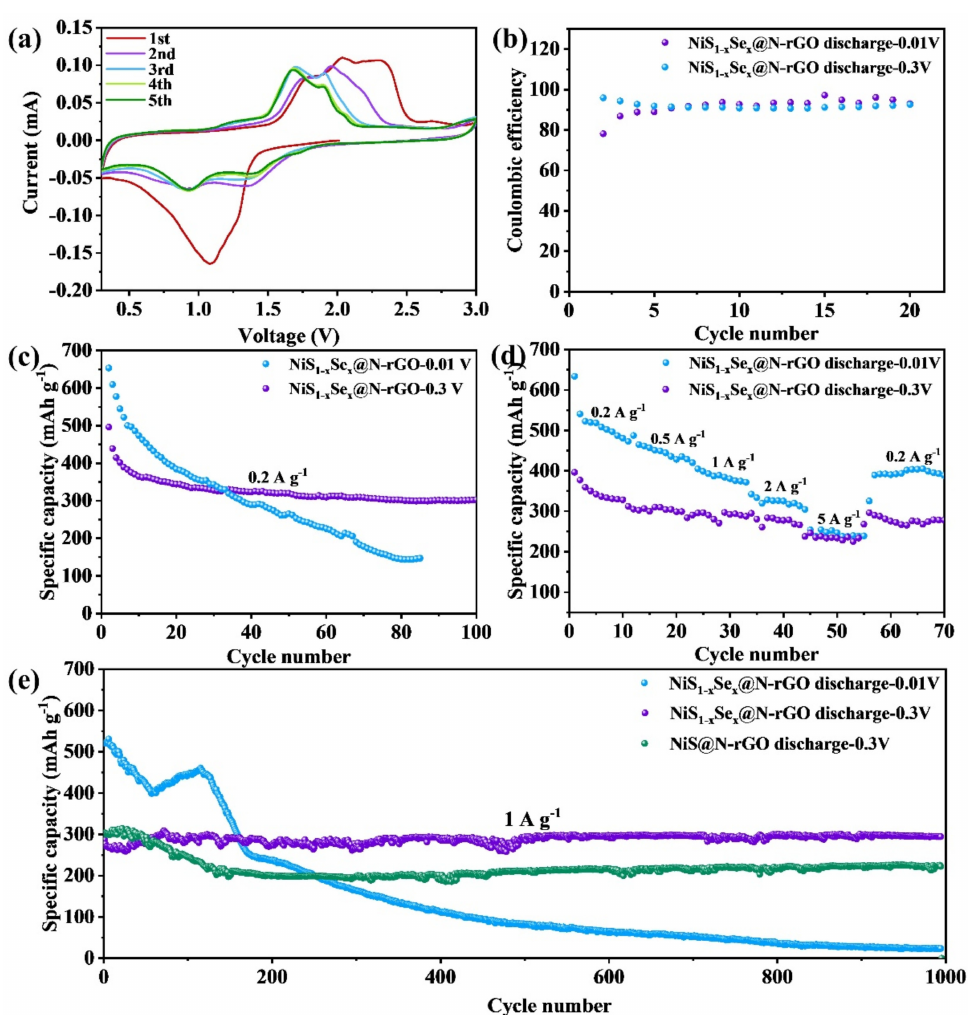
Figure 5. ( a ) CV curves at 0.3–3 V of NiS 1 − x Se x @N–rGO. ( b ) Coulombic efficiency at 0.2 A g − 1 . ( c , d ) the cycling performance at 0.2 A g − 1 and rate performance of the NiS 1 − x Se x @N–rGO electrode at different cut-off voltages. ( e ) The cycling performance of NiS 1 − x Se x @N–rGO and NiS@N–rGO electrode at 1 A g − 1